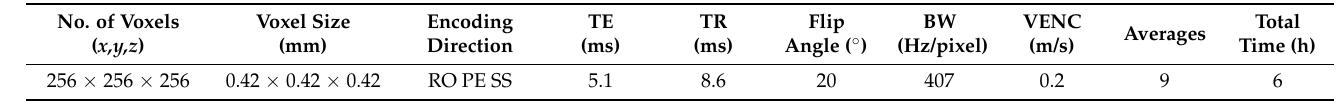
Table 1. Description of the sequence